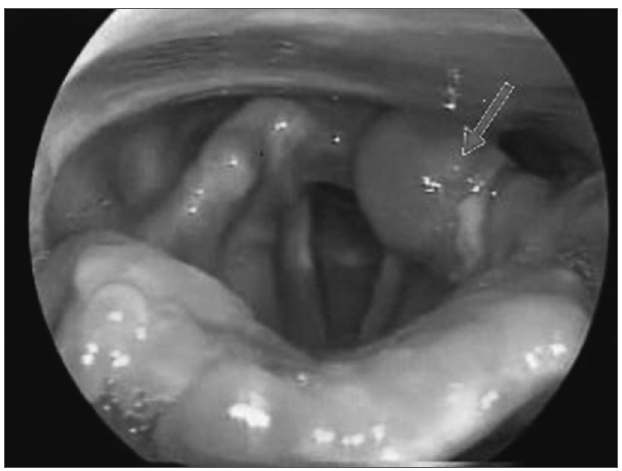
Figure 3. Atypical aphthous lesion in left arytenoidal region.